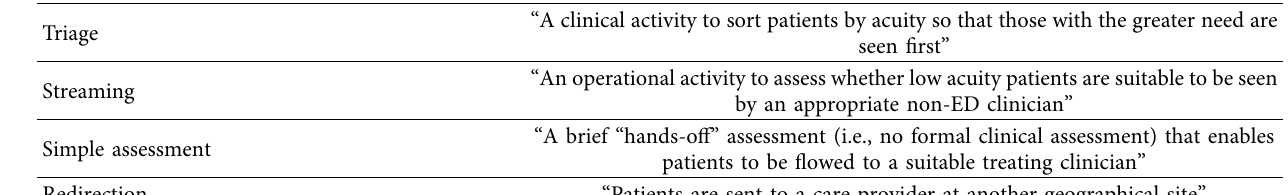
Table 2: Allocation and redirection